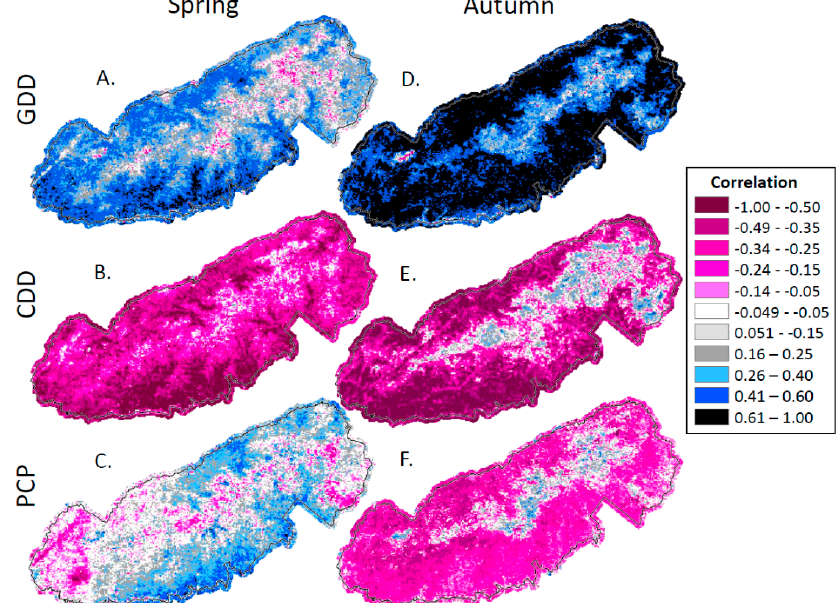
Figure 7. Correlations of mid-spring and mid-autumn NDVI with antecedent weather: ( A ) Correlation of spring NDVI with growing degree days (GDD); ( B ) spring NDVI with chilling degree days (CDD); ( C ) spring NDVI with precipitation (PCP); ( D ) autumn NDVI with autumn GDD; ( E ) autumn NDVI with autumn CDD; and ( F ) autumn NDVI with autumn PCP. Spring weather variables are lagged by two eight-day periods and the autumn variables are lagged by four periods compared to NDVI (see Figure 6 for context).